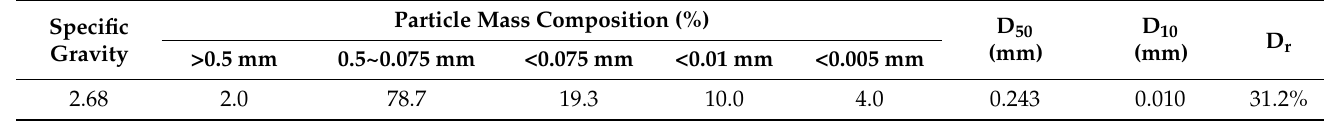
Table 1. Grain size distribution of silty-fine sand.